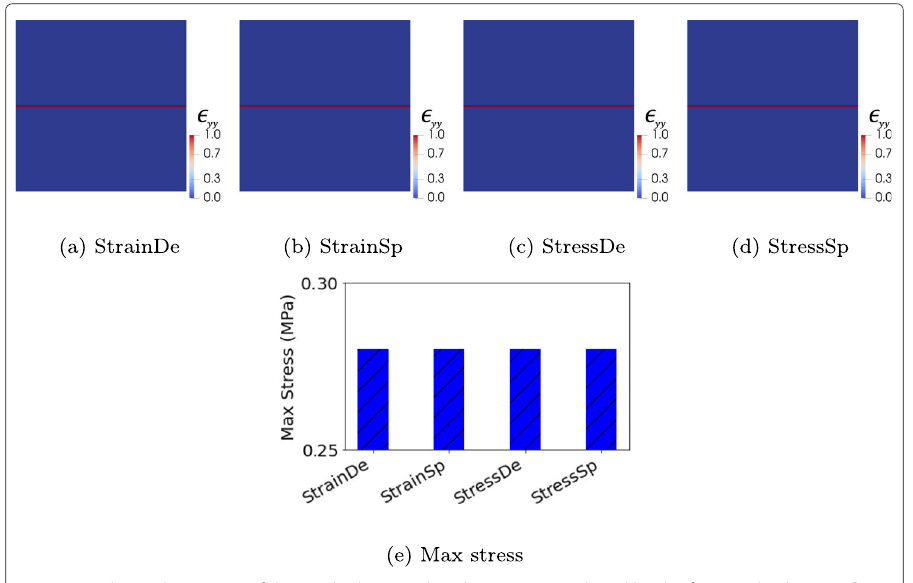
Fig. 2 Mechanical response of the cracked material under tension predicted by the four methods: ( a ) - ( d ) strain distribution for the strain deviatoric, strain spectral, stress deviatoric, and stress spectral methods, respectively; ( e ) maximum tensile stress throughout the